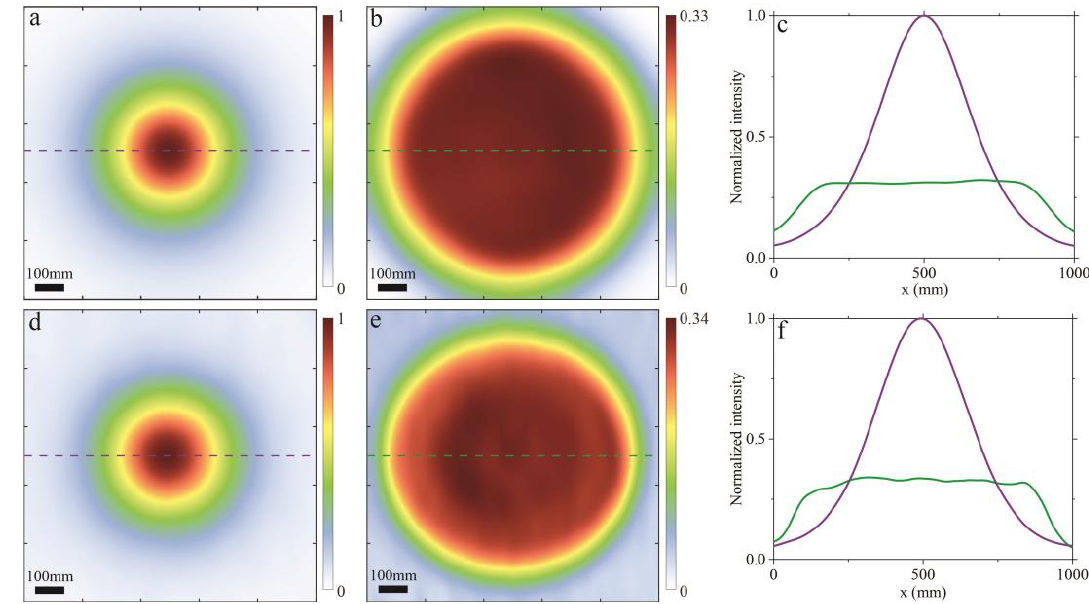
Figure 5. Simulation and experimental results for a target plane located 25 cm away from the source. ( a ) ZEMAX simulation result for OSRAM LED rayfile without the lens. Dashed purple line indicates the middle row. ( b ) Simulation result for OSRAM LED rayfile with the lens. ( c ) Comparing middle rows’ irradiances (dashed horizontal lines on Figure 2a,b) of the simulation result with (green curve) and without (purple curve) the lens. ( d ) Normalized irradiance for experimental result without the lens. ( e ) Normalized irradiance for experimental result with the lens. ( f ) Comparing middle rows’ irradiances of the experimental result with (green line) and without (purple line) the lens.